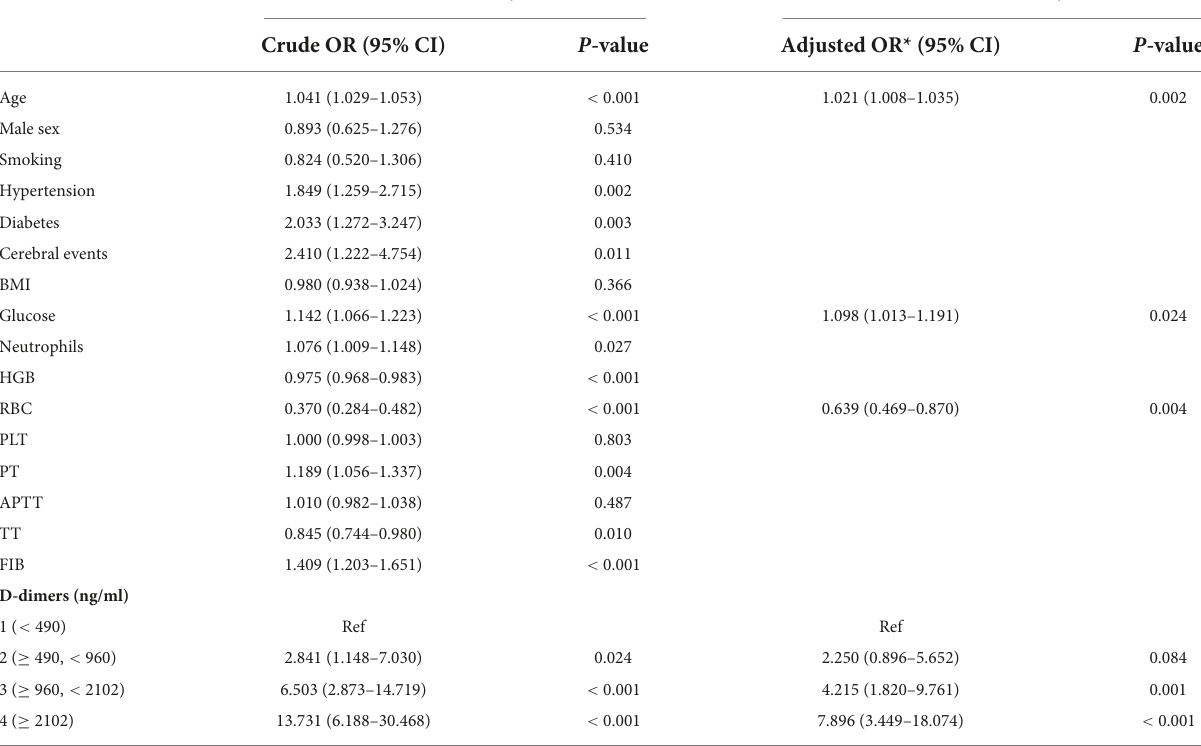
TABLE 2 Risk factors associated with DVT by univariate and multivariate